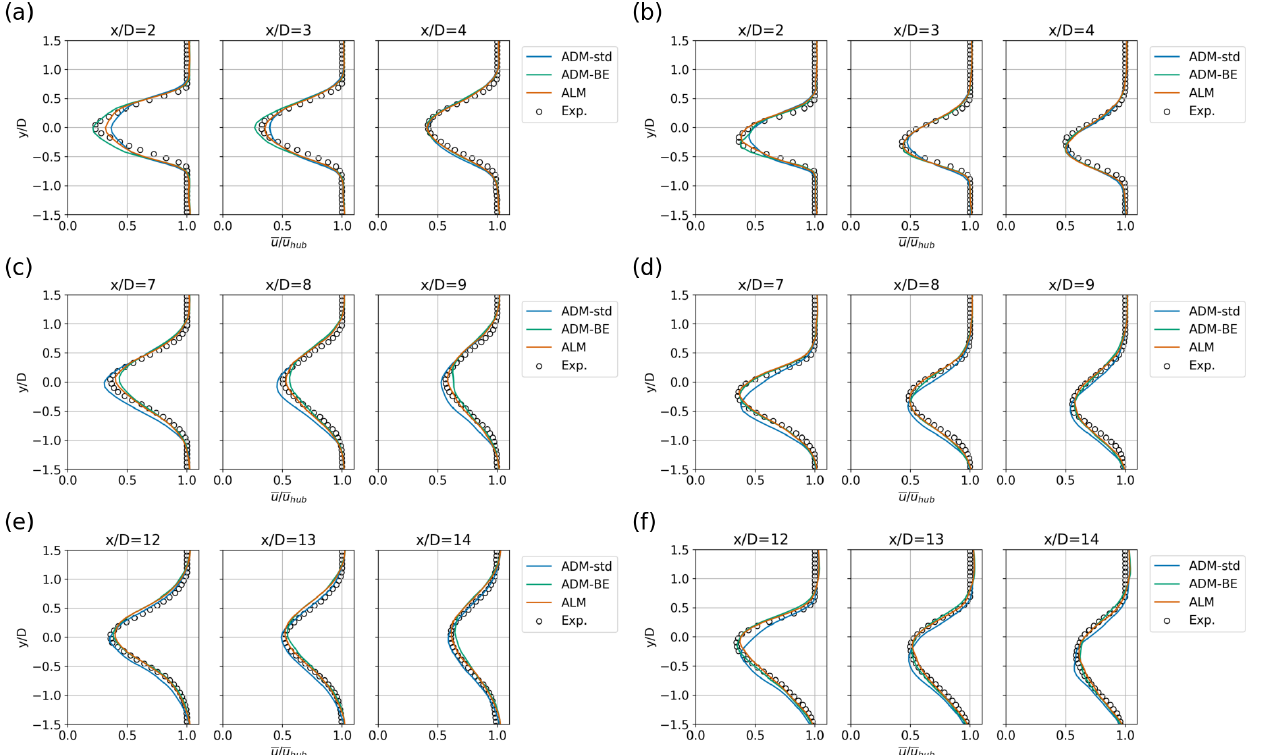
Figure 5. Spanwise profiles of the normalised streamwise mean velocity u/u hub in the x − y plane at hub height obtained from the wind- tunnel experiments and LES using the ADM-std, ADM-BE and ALM. The lateral offset of the turbines is zero (Cases 1 and 2). (a) WT 1, γ = (0 , 0 , 0 ◦ ); (b) WT 1, γ = (25 , 15 , 0 ◦ ); (c) WT 2, γ = (0 , 0 , 0 ◦ ); (d) WT 2, γ = (25 , 15 , 0 ◦ ); (e) WT 3, γ = (0 , 0 , 0 ◦ ); (f) WT 3, γ = (25 , 15 , 0 ◦